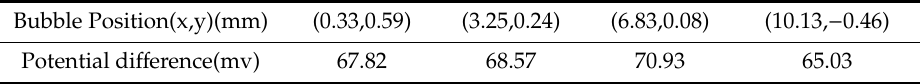
Table 4. Induced potential di ff erence when the bubble is on the